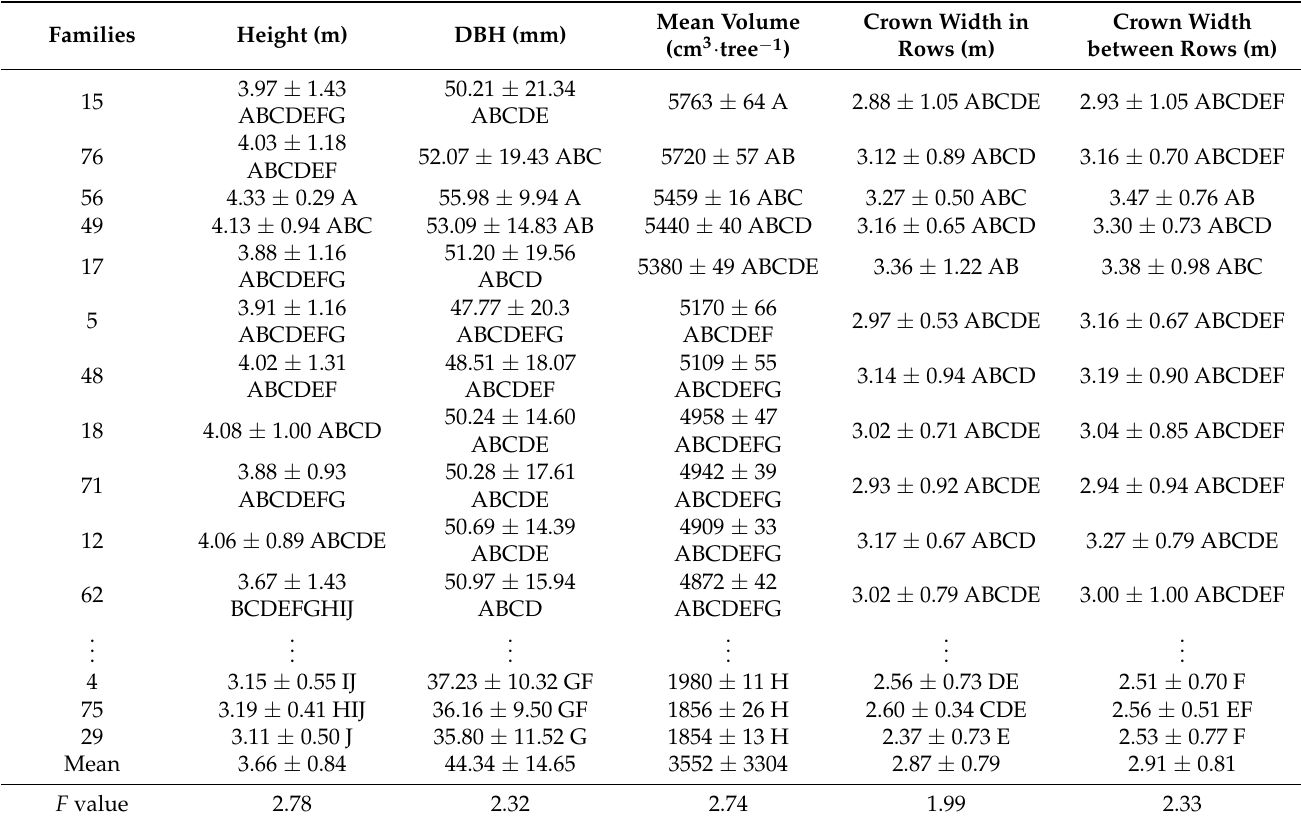
Table 3. Growth performance of C. axillaris families at 3 years old.